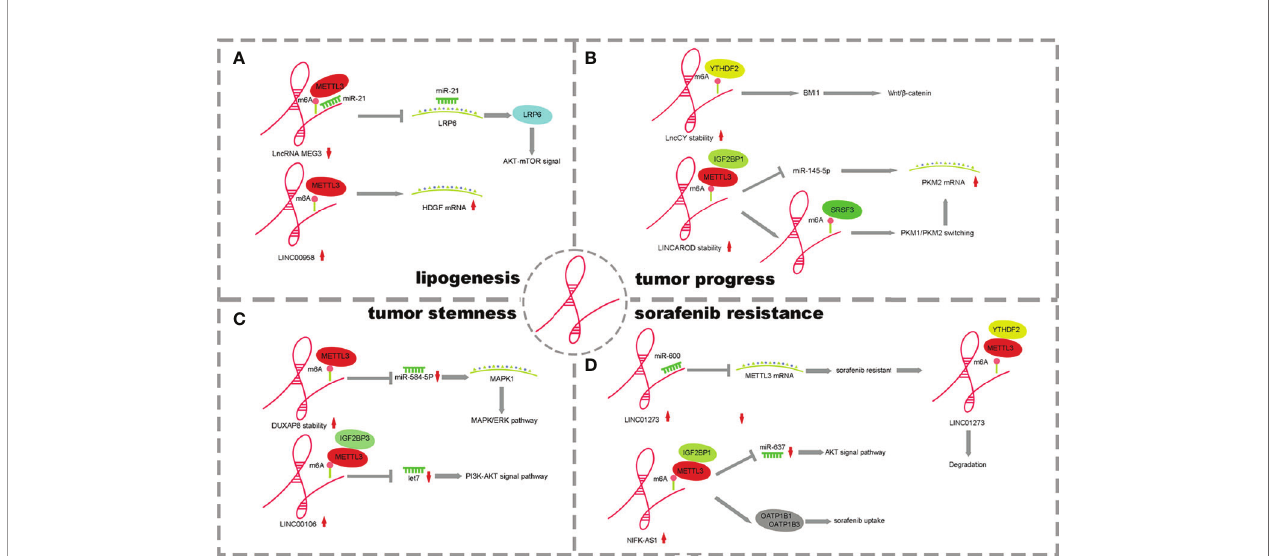
FIGURE 3 | The mechanism of lncRNA m6A regulatory factors and their in fl uence. (A) m6A of lncRNAs promote lipogenesis. (B) m6A of lncRNAs effect HCC Processes. (C) m6A of lncRNAs enhance tumor stemness. (D) m6A of lncRNAs in fl uence drug resistance on tumor